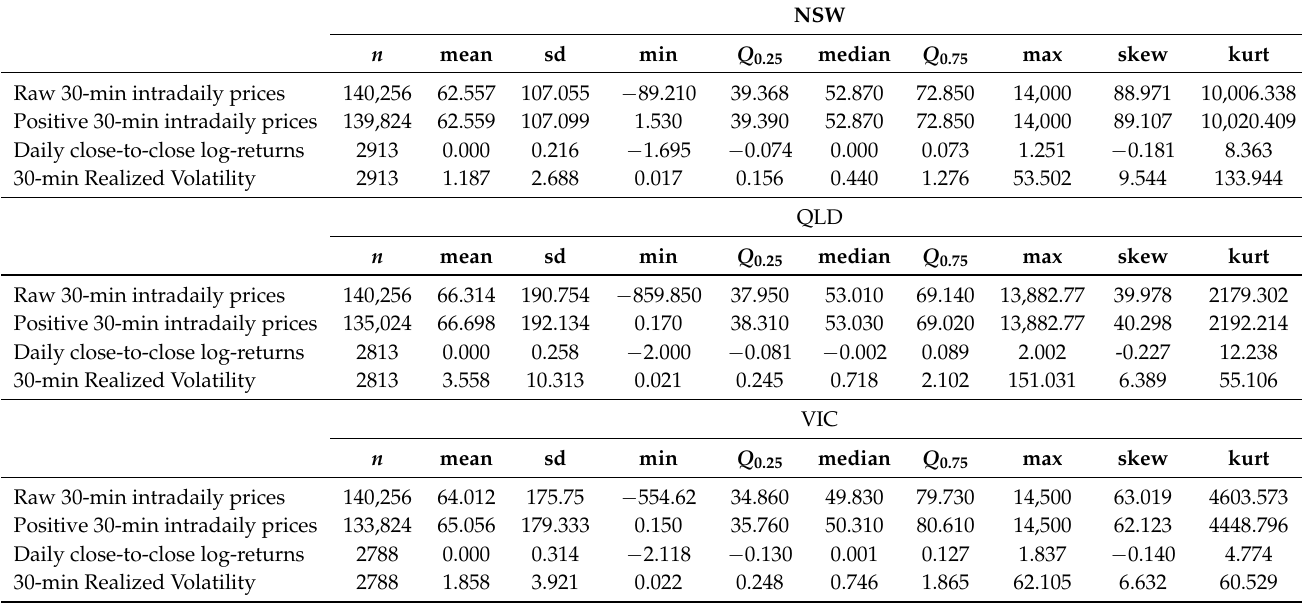
Table 1. Summary